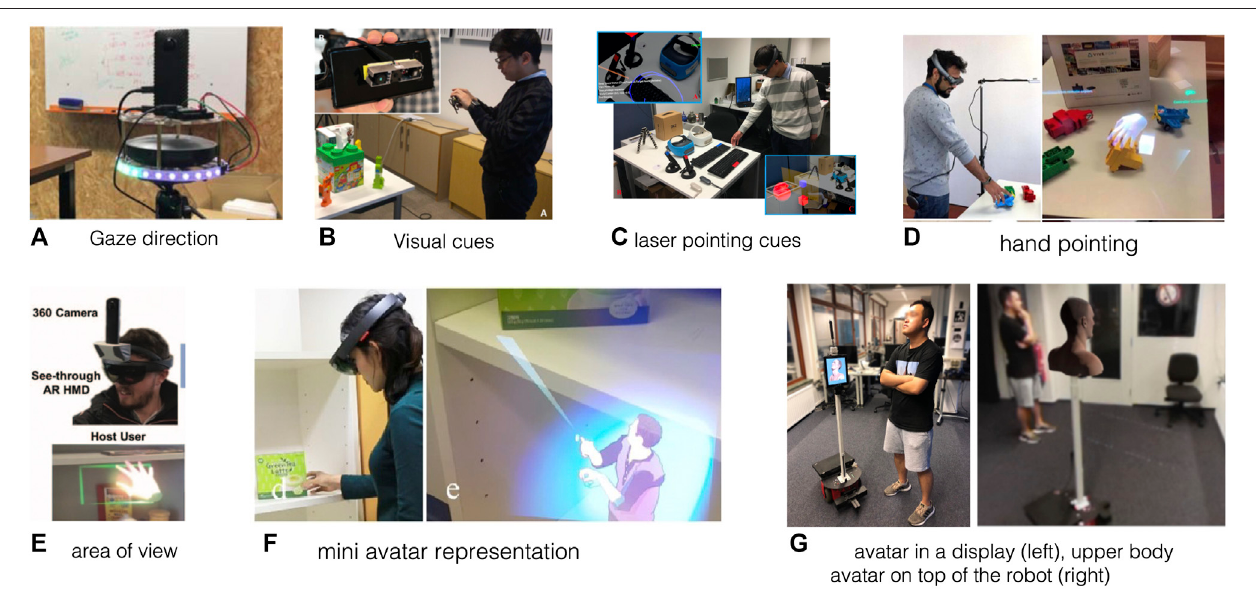
FIGURE 5 | Representative examples from reverse side of asymmetric immersive communication archetypes. From left to right and top to bottom: (A) led ring showingvisitorgazedirection(Izumiharaetal.,2019), (B) phonedisplayingvisitorcues(Gaoetal.,2018), (C) ARglassesdepictinglaserpointingcues(Gaoetal.,2020), (D) AR glasses depicting hand pointing (Sasikumar et al., 2019), (E) AR glasses depicting area of Lee et al. (2018), (F) AR glasses depicting a mini representation of the visitor pointing to some object (Piumsomboon et al., 2018), and (G) avatar in a display (left), upper body avatar on top of the robot (right) (Zhang et al., 2020)